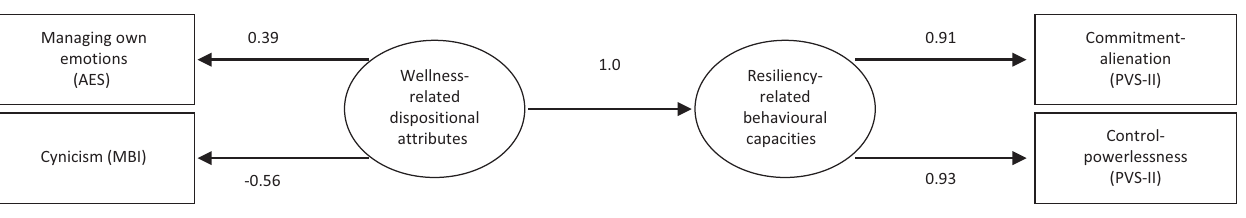
its variables and the standardised path coefficients between the resiliency-related behavioural capacities and its variables as per the best fit model. The standardised path coefficient estimates between the wellness-related dispositional attributes construct and the resiliency-related behavioural capacities construct are also specified. Similar to the results